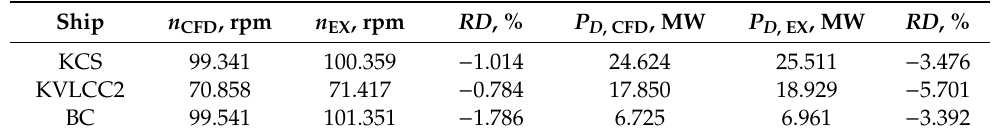
Table 11. The validation study for self-propulsion